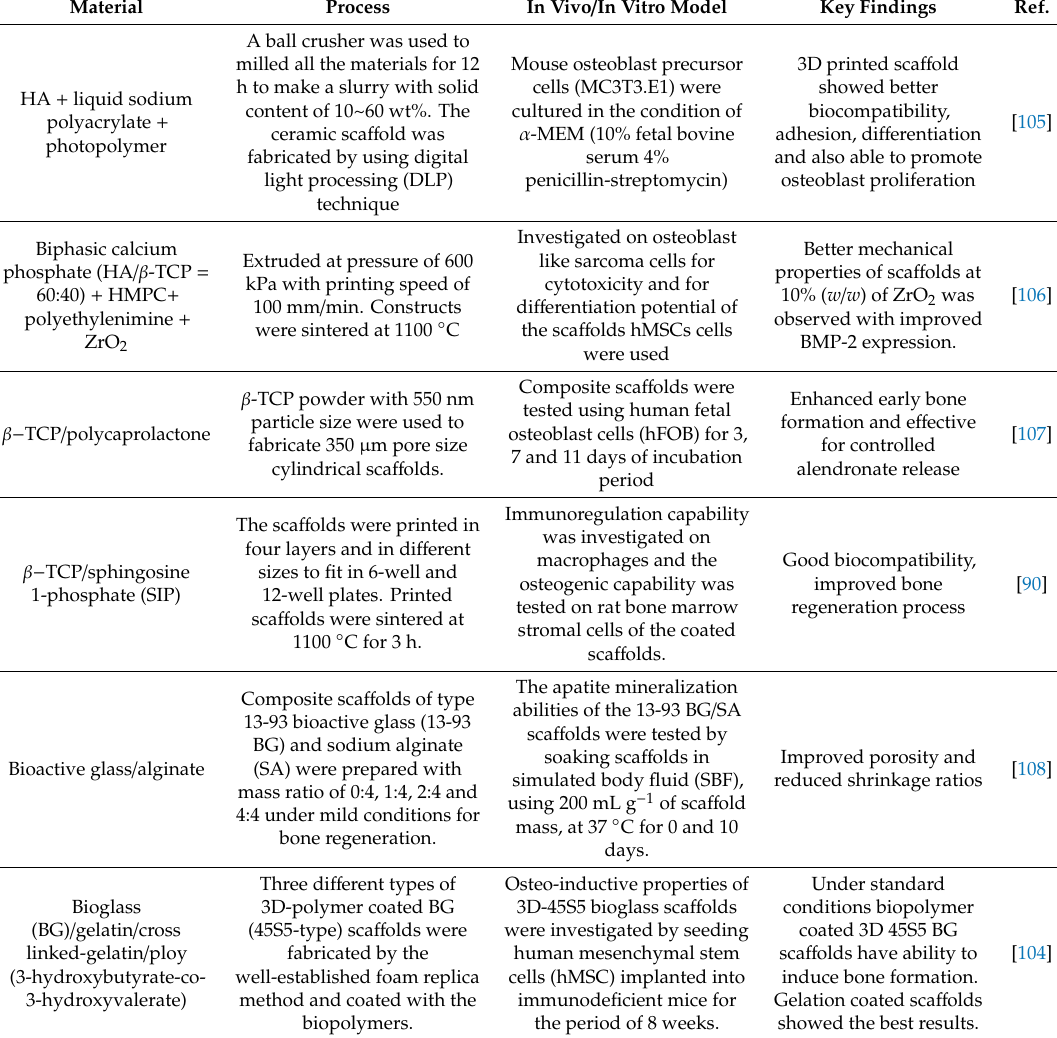
Figure 13. Histomorphometric and micro-CT analysis showing new bone development in polymer coated Bioglass (BG) scaffolds inserted in mice for eight weeks [104]. Table 4. Overview of 3D printed bioceramics for bone tissue